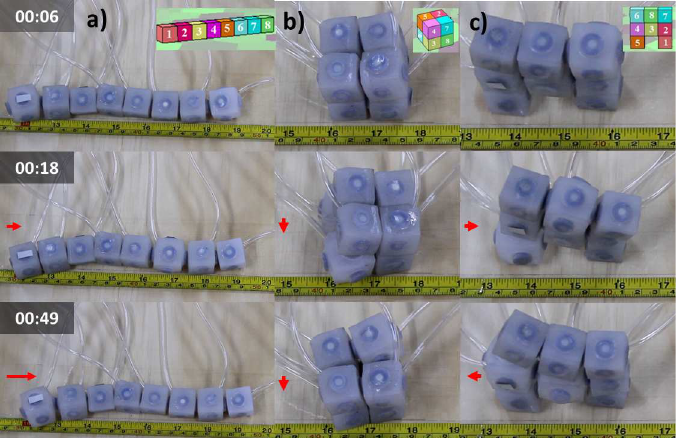
Fig 5. Instantaneous images taken during the locomotion of three different systemsassembled using soft modular robotic units. a) System 1, a worm configuration,b) System 2, a 2 × 2 × 2deformable cube c) System 3, a two leggedmachine.The timestamp is displayedon the left column in minutes:seconds format. Corresponding simulatedsystems are displayedon top. Red arrows indicate an estimated displacement